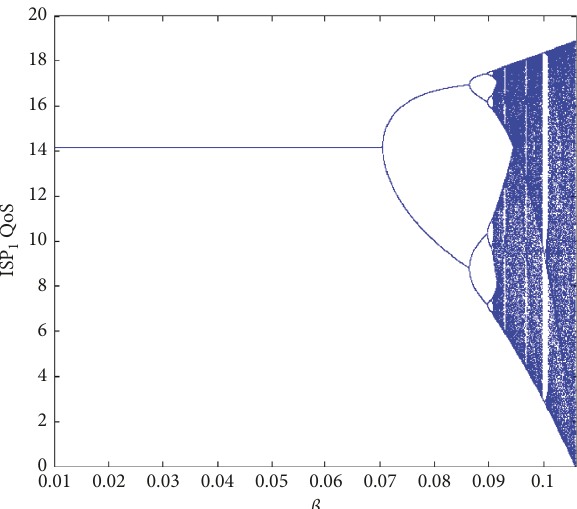
Figure 10: Bifurcation diagrams of q